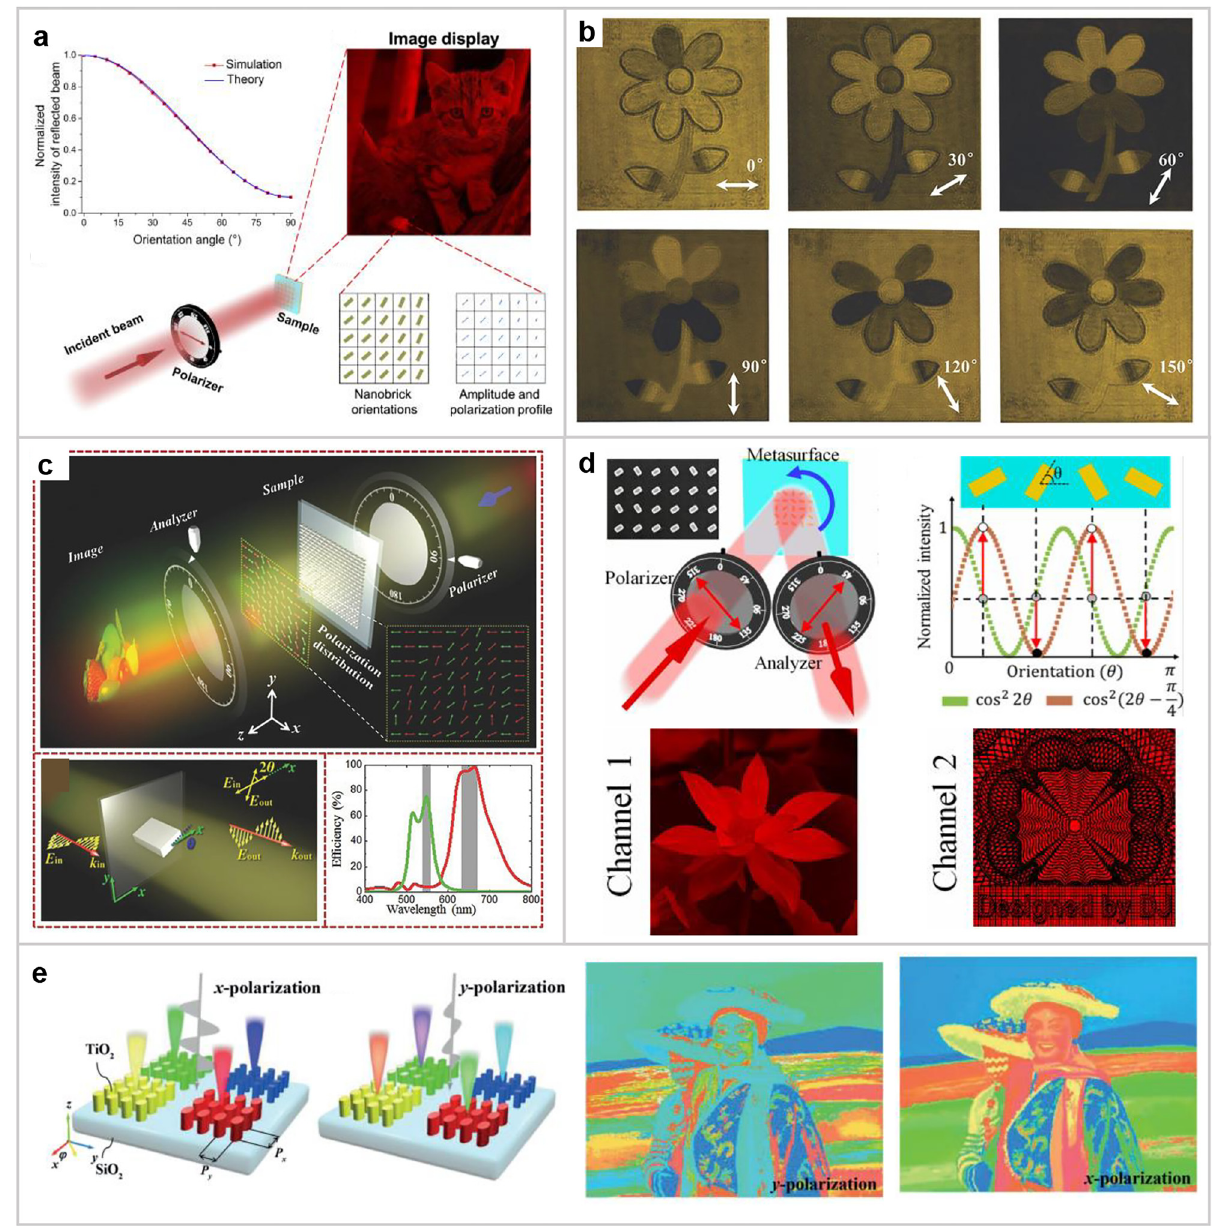
Figure 7: Applications of polarization-based nano-printing with all-dielectric metasurfaces. A Si metasurface that realizes the gray-scale imagedisplay,wherethemeta-atomsinsideactas(a)polarizers[117]or(b)halfwaveplatesbycombingtheanalyzerattheoutputend[118].(c) A metasurface device to encode the color grayscale image into several sets of polarization pro fi les utilizing the wavelength selectivity of the geometric phase elements [119]. (d) A dual-channel polarization-dependent metasurface for nano-printing display composed of the single- sized Si meta-atoms [120]. (e) A TiO 2 metasurface for polarization-dependent structural color in the reffection mode in the visible range applying different resonance response of the asymmetric structure along the orthogonal axes [121]. Reprint permission obtained from [117 – length and width. By tailoring the periodicity of the meta- switchable bi-functional Si metasurface for anomalous atom, the beam de fl ection angle and focusing distance can beam de fl ection and focusing in the visible band as shown be ef fi ciently tuned. By further utilizing the ability of multi- in Figure 8a. A rectangular meta-atom is used to design two parameter control of polarization, amplitude, and phase distinct propagation phase pro fi les for beam de fl ection and by ADM, researchers have explored integrating more focusing along the fast and short axes by changing its